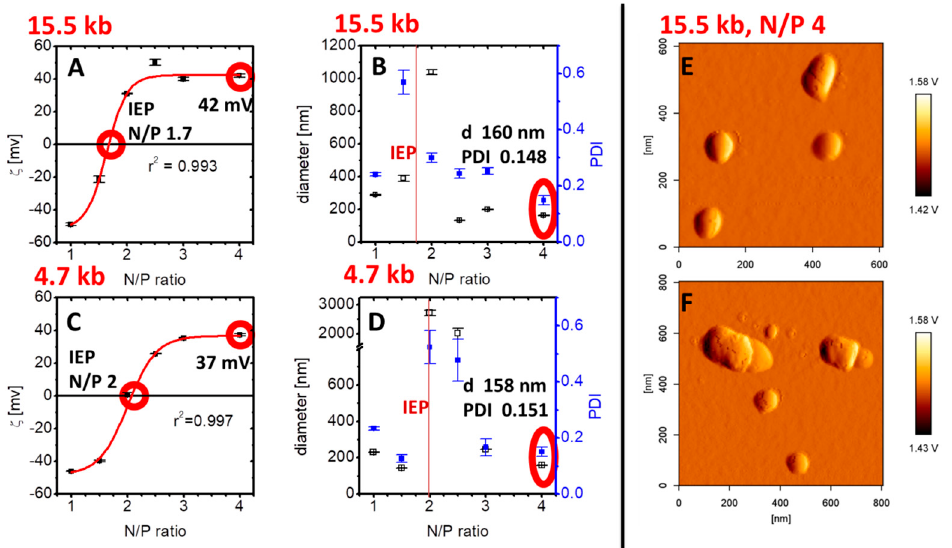
Figure 2. Zeta potential (mean and standard deviation of 3 measurements consisting of 30 runs, ( A , C ) and particle size (z- average diameter and the corresponding polydispersity index (PDI), mean and standard deviation of 3 measurements consisting of 15 runs, B , D ) as a function of the N / P ratio, a value for the degree of loading the lipid formulation with DNA of di ff erent size: 15.5 kb ( A , B ) and 4.7 kb ( C , D ). Representative atomic force microscopy (AFM) images of OH4 / DOPE 1 / 1 (n / n) in the complex with 15.5 kb DNA at N / P 4 are shown ( E , F ).